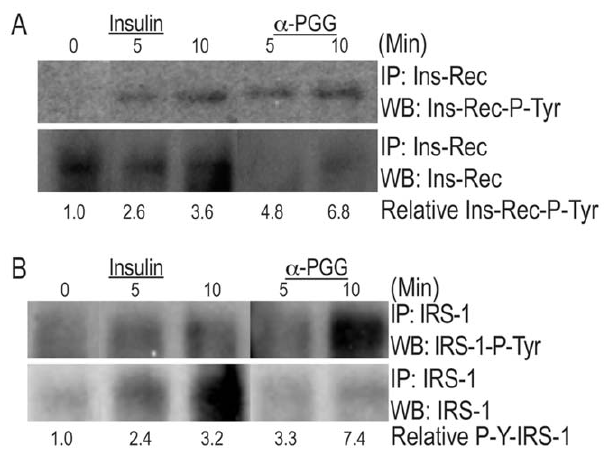
Figure 1. Insulin or a -PGG induced phosphorylation of insulin receptors and IRS-1. Washed human platelets were incubated with insulin (100 nM) or a -PGG (10 m M) for five and ten minutes. The reactions were stopped by adding lysis buffer and the total and phosphorylated insulin receptors (A) and total IRS-1 and phosphorylat- ed IRS-1 (B) were visualized after immuno-precipitation and Western blotting. The phosphorylation of insulin receptors and IRS-1 was quantified by densitometry.